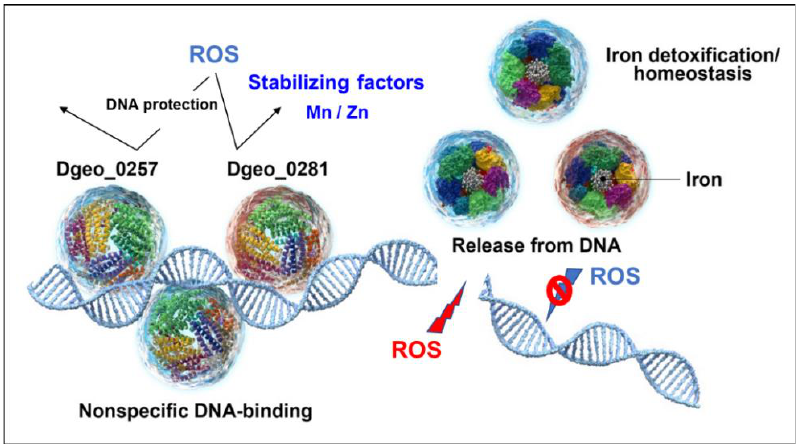
Figure 7. Regulatory scheme of DgDps1 (Dgeo_0281) and Dgeo_0257. Both DgDps1 and Dgeo_0257 proteins act as DNA protectants under oxidative stress conditions. DNA-binding stability was en- hanced by Mn and Zn ions. When Dps proteins were released from DNA, iron ions were sequestrated to repress the Fenton reaction. However, free DNA damaged by ROS results in DNA cleav- age.